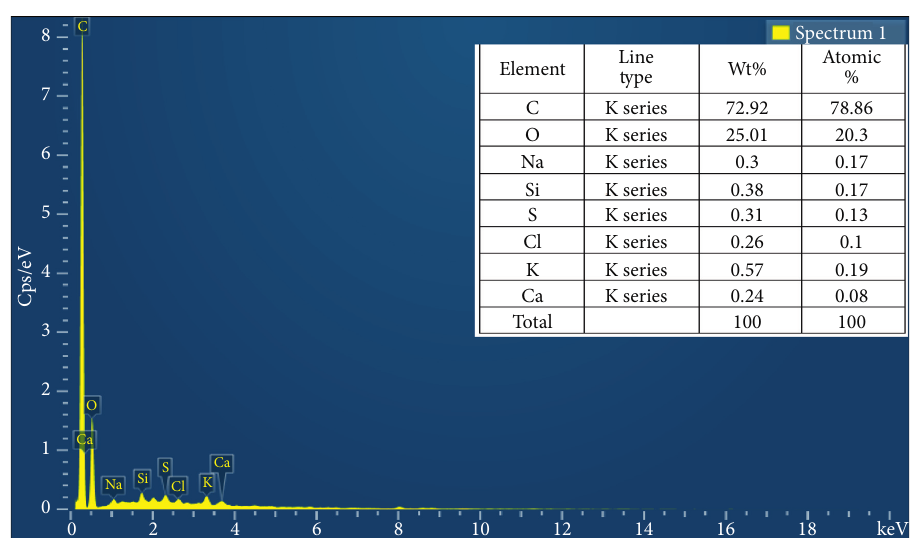
Figure 10: Elemental composition of rGO using